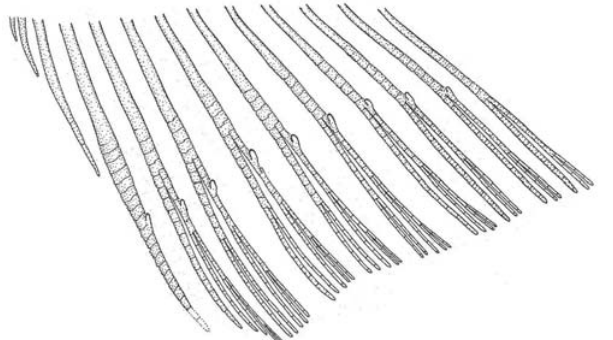
Fig. 81. Mimagoniates microlepis , large adult male, USNM 249876, 59.3 mm SL; anterior 13 anal-fin rays, lateral view, left side.